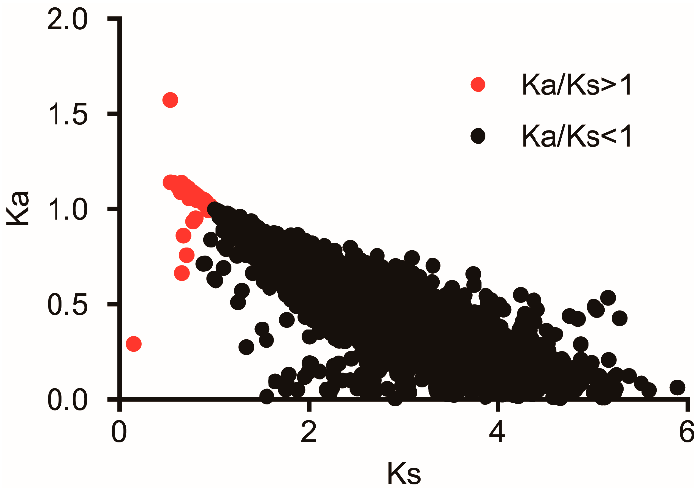
Figure 4. Distribution of Ka and Ks in 6627 orthologous gene pairs between Donacia provosti and Leptinotarsa decemlineata .